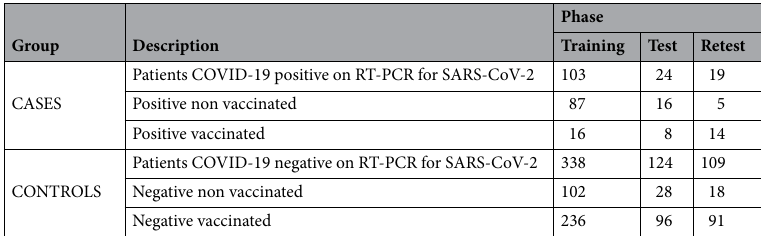
Table 6. Groups and sample size of training and test–retest